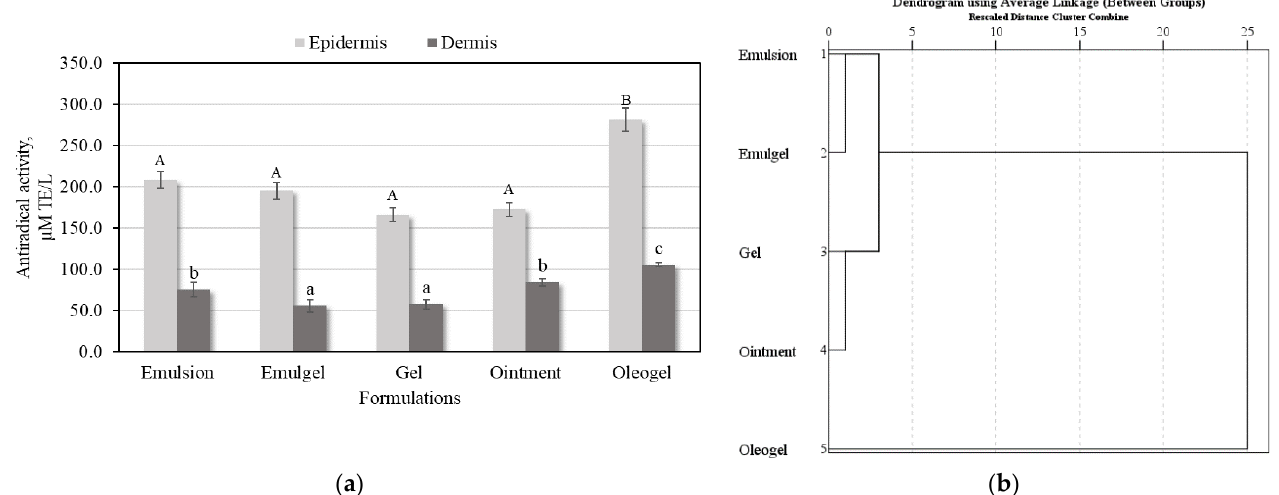
Figure 6. Results of antioxidant activity studies: ( a ) Antiradical activities of human skin extracts after applying semi-solid formulations with a mixture of phenolic compounds solution; ( b ) The den-drogram illustrates variation in the antioxidant activities of human skin extracts after applying semi-solid formulations with a mixture of phenolic compounds solution. Uppercase and lowercase letters indicate a statistically significant difference in the antiradical activities between semi-solid formu-lations ( p < 0.05).